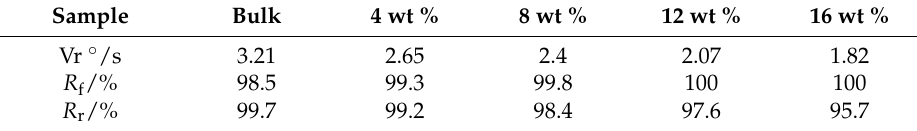
Table 1. Effect of SiCw content on the shape memory properties of the hydro-epoxy system.